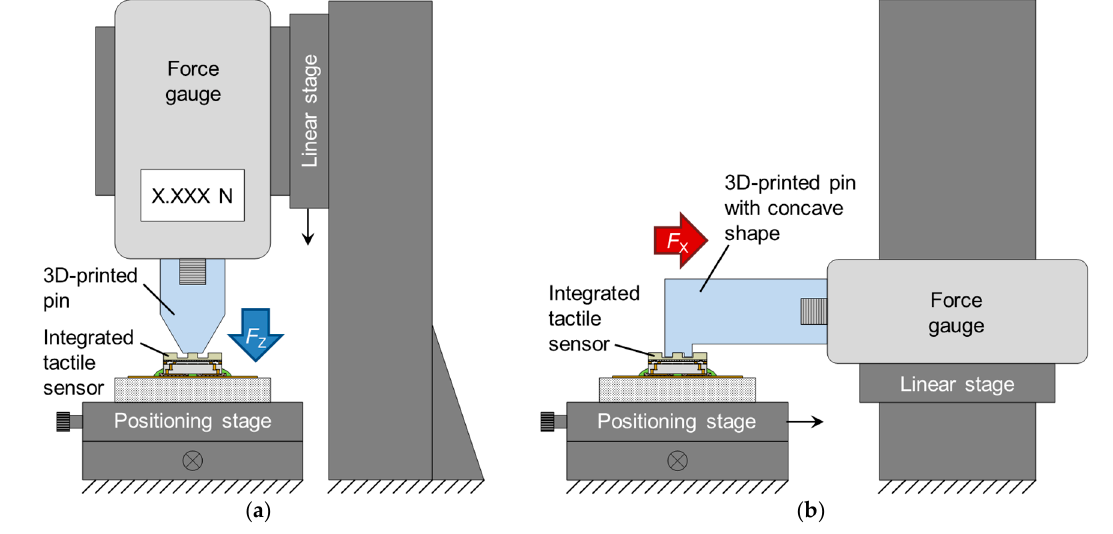
Figure 10. Measurement setup for applying ( a ) normal force and ( b ) shear force.